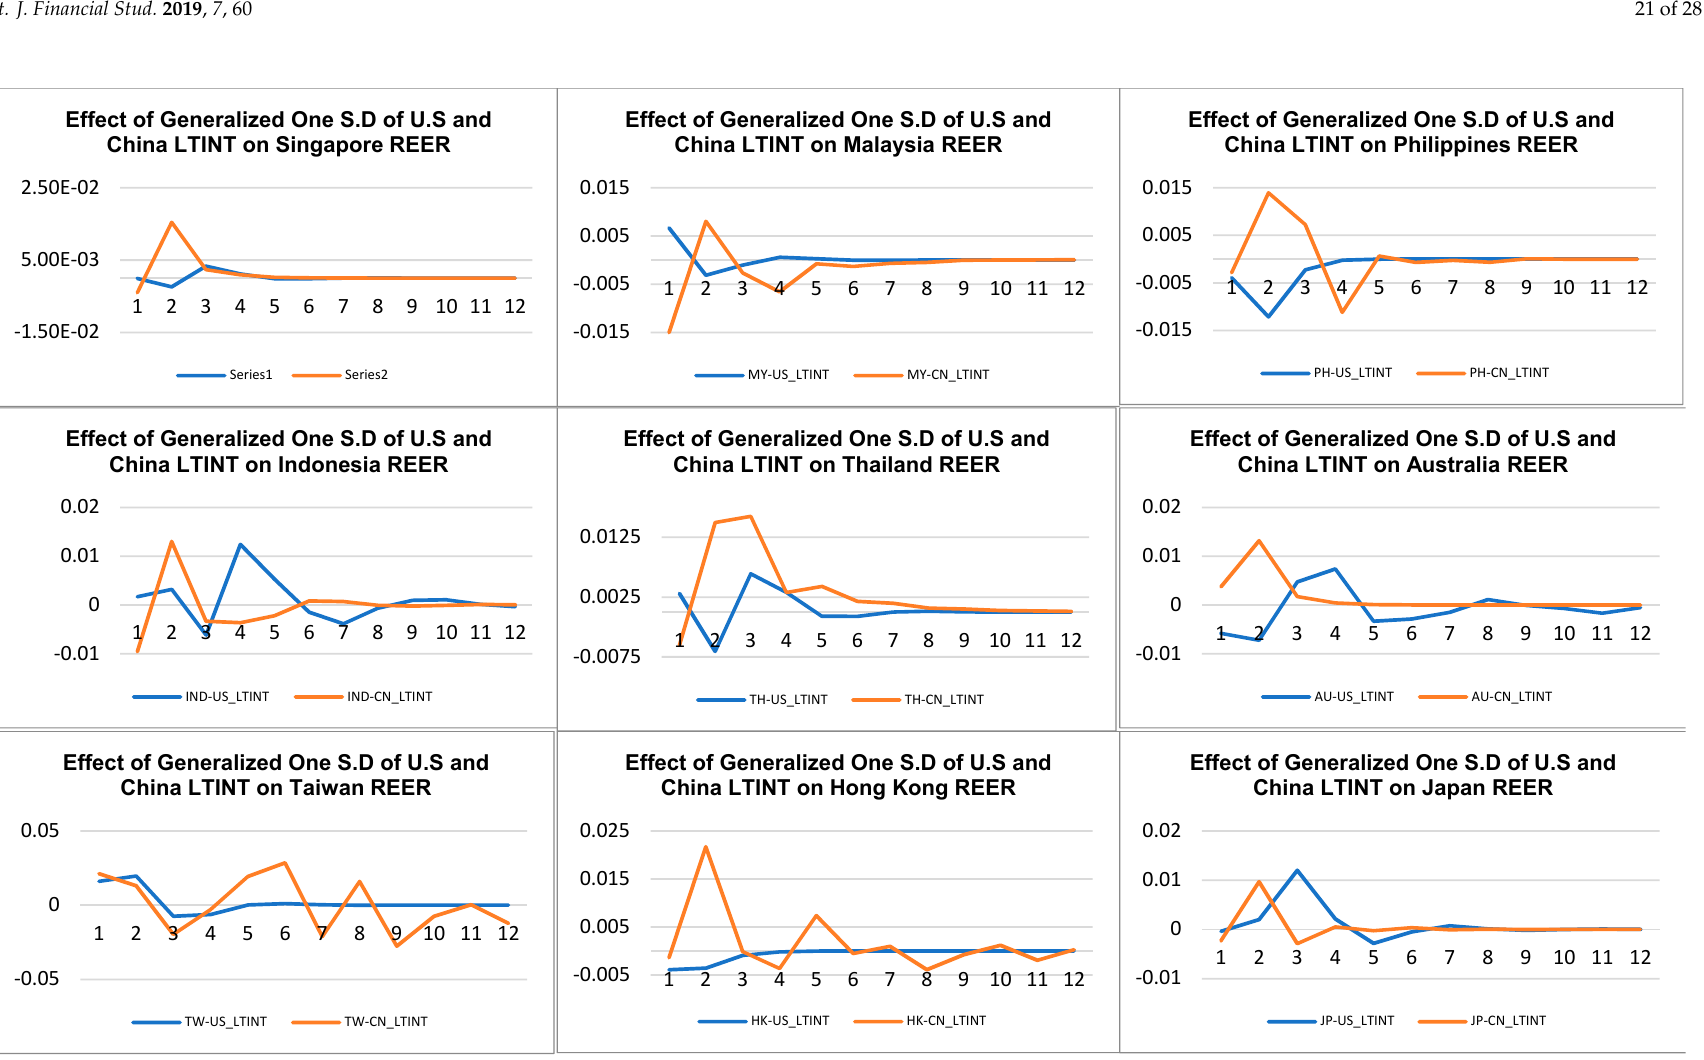
Figure 3. VAR estimations of the impact of innovations of one standard deviation in the US and China long-term interest rate (LNINT) on the APAC REERs.